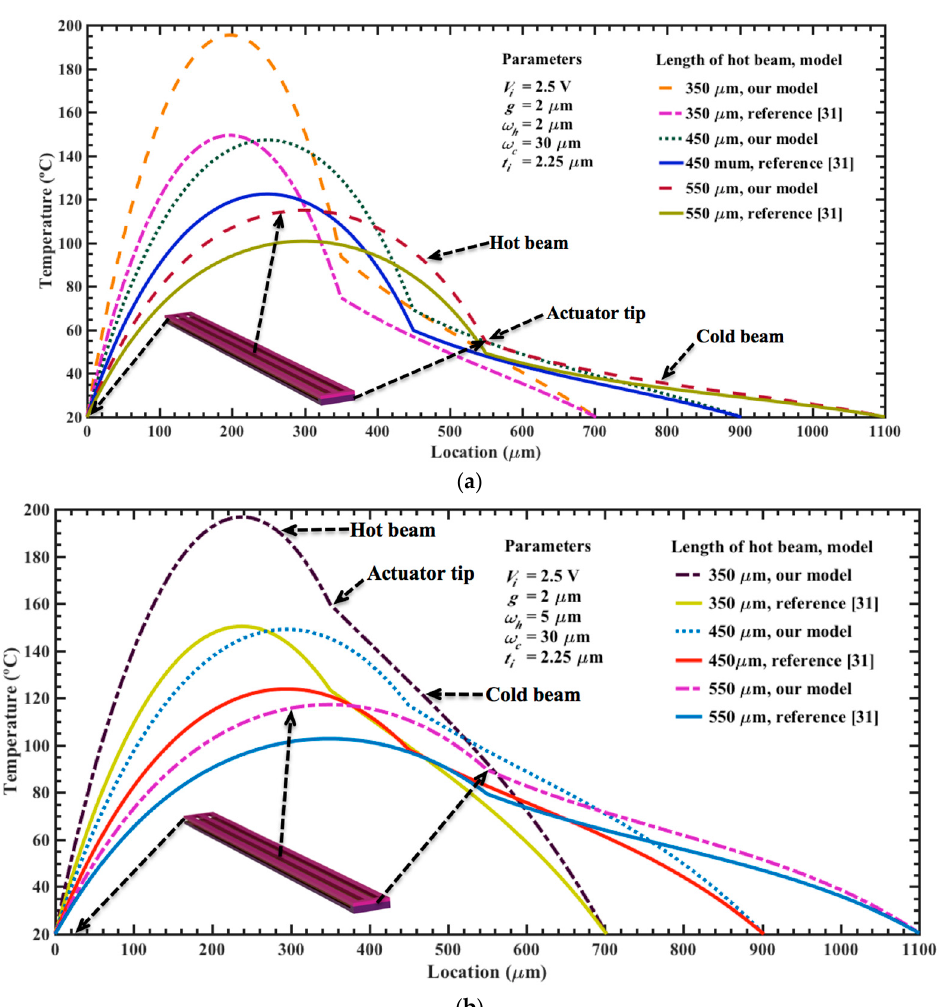
Figure 7. Distribution of the temperature along of the upper (hot) and bottom (cold) beams of an electrothermal actuator, which considers different lengths (350 μ m to 550 μ m) and two width values for the upper beams: ( a ) 2 μ m; and ( b ) 5 μ m.